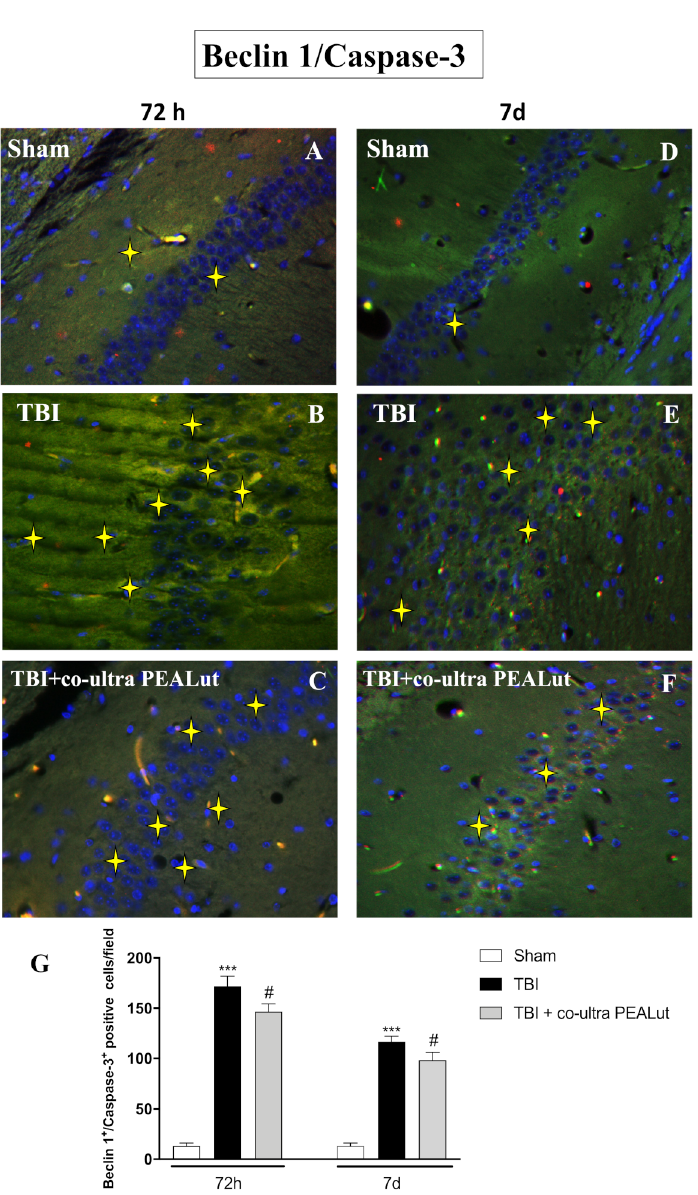
Figure 4. Co-ultra PEALut treatment counteracts neurodegeneration, slowing down programmed cell death. A considerable number of Beclin 1/Caspase-3-positive cells were identified in TBI-72 h ( B , G ) and TBI-7 d ( E , G ) mice, matched to the corresponding control group ( A , D , G ). Treatment with co-ultra PEALut reduced this positive expression both 72 h ( C , G ) and 7 d ( F , G ) post-TBI. Magnification 40 × . Yellow stars indicate the positive staining for Beclin 1/Caspase-3. Data are expressed as Mean ± SEM from N = 10 mice for each group. One-way ANOVA test. *** p < 0.001 vs. corresponding Sham group; # p < 0.05 vs. corresponding